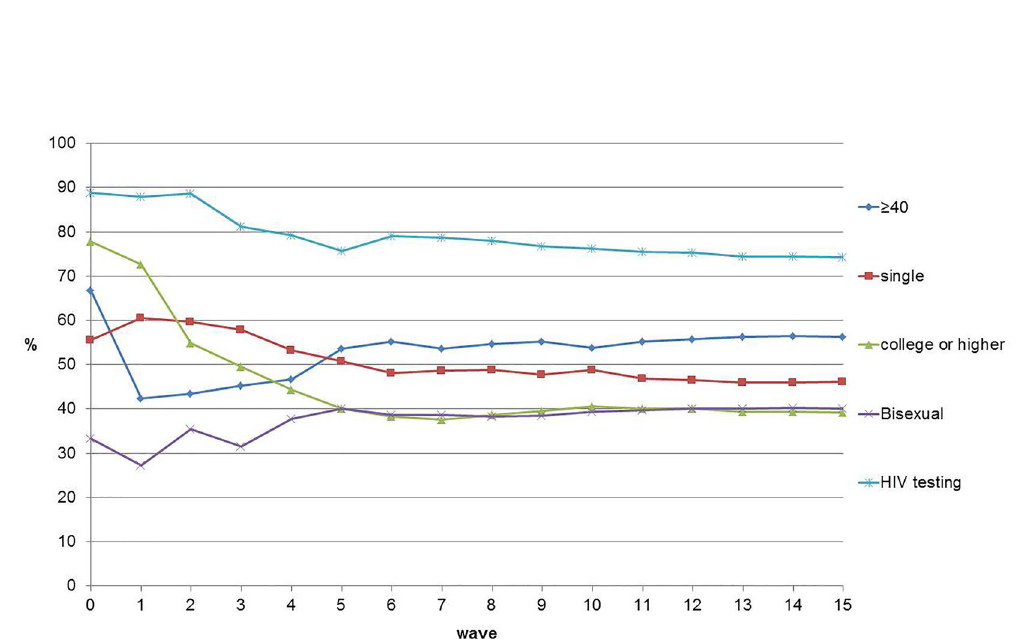
Figure 3. Sample equilibrium by age, martial status, education, sexual orientation and HIV